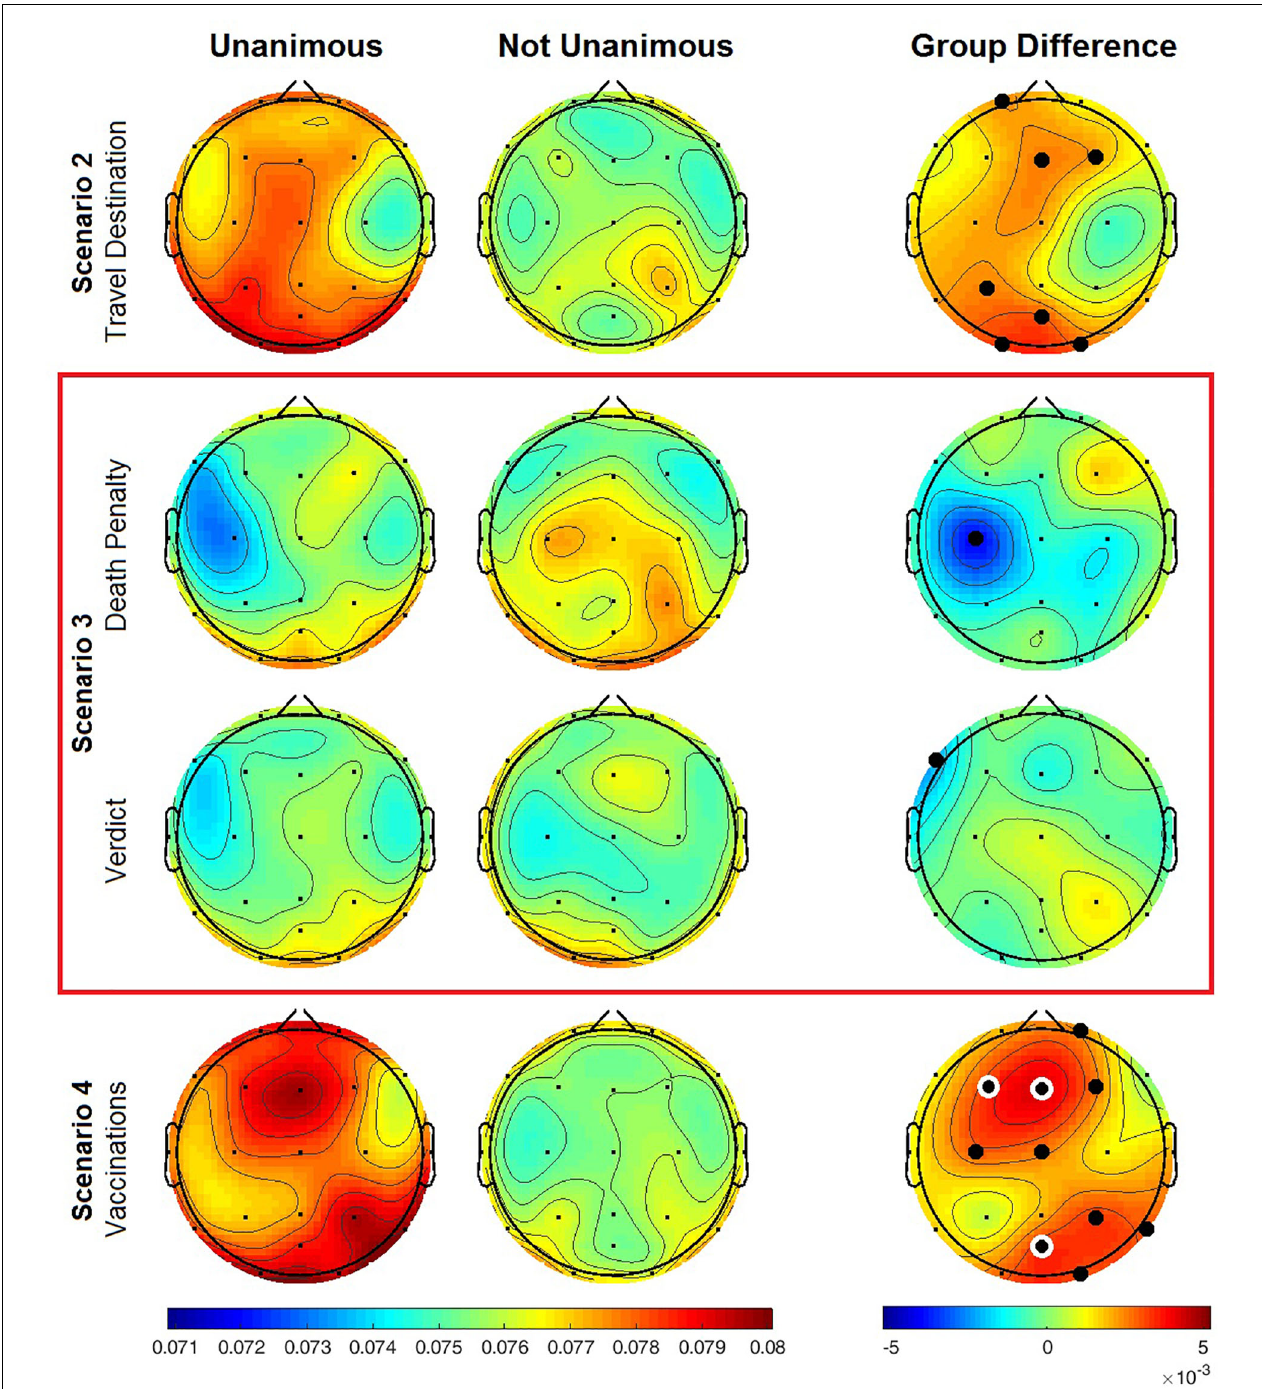
FIGURE 3 | Inter-brain coherence in gamma frequency band during each scenario by group unanimity. Red box contains topological maps for the two issues in scenario 3, concordant or discordant stances on death penalty, and the guilty or innocent verdict for alleged murder suspect. Sample sizes are for number of subject pairs. Significant EEG channels at α = 0.05 denoted by black filled circle, those marked with white ring are significant after FDR correction for multiple